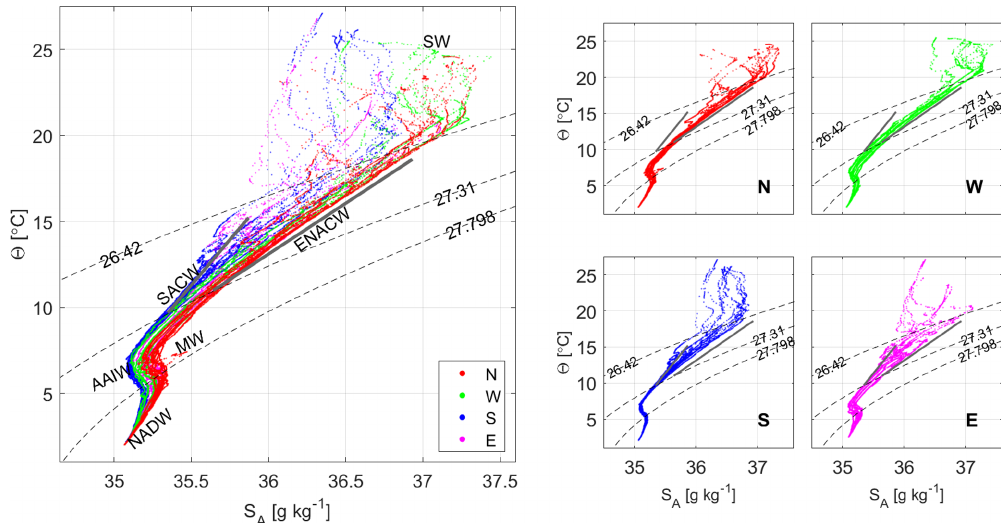
Figure 4. (cid:50) − S A diagrams during the FLUXES-I cruise. The different water masses in the northern (N, red dots), western (W, green dots), southern (S, blue dots) and eastern (E, pink dots) transects for surface waters (SW), North Atlantic Central Water (ENACW), South Atlantic Central Water (SACW), modified Antarctic Intermediate Water (AAIW), Mediterranean Water (MW) and North Atlantic Deep Water (NADW). Potential density anomaly contours (gray dashed lines) equivalent to 26.46, 27.4 and 27.922kgm − 3 isoneutrals delimit the surface, central, intermediate and deep water levels. Straight lines represent the (cid:50) − S A relationship for ENACW and SACW equivalent to that proposed by Tomczak (1981).